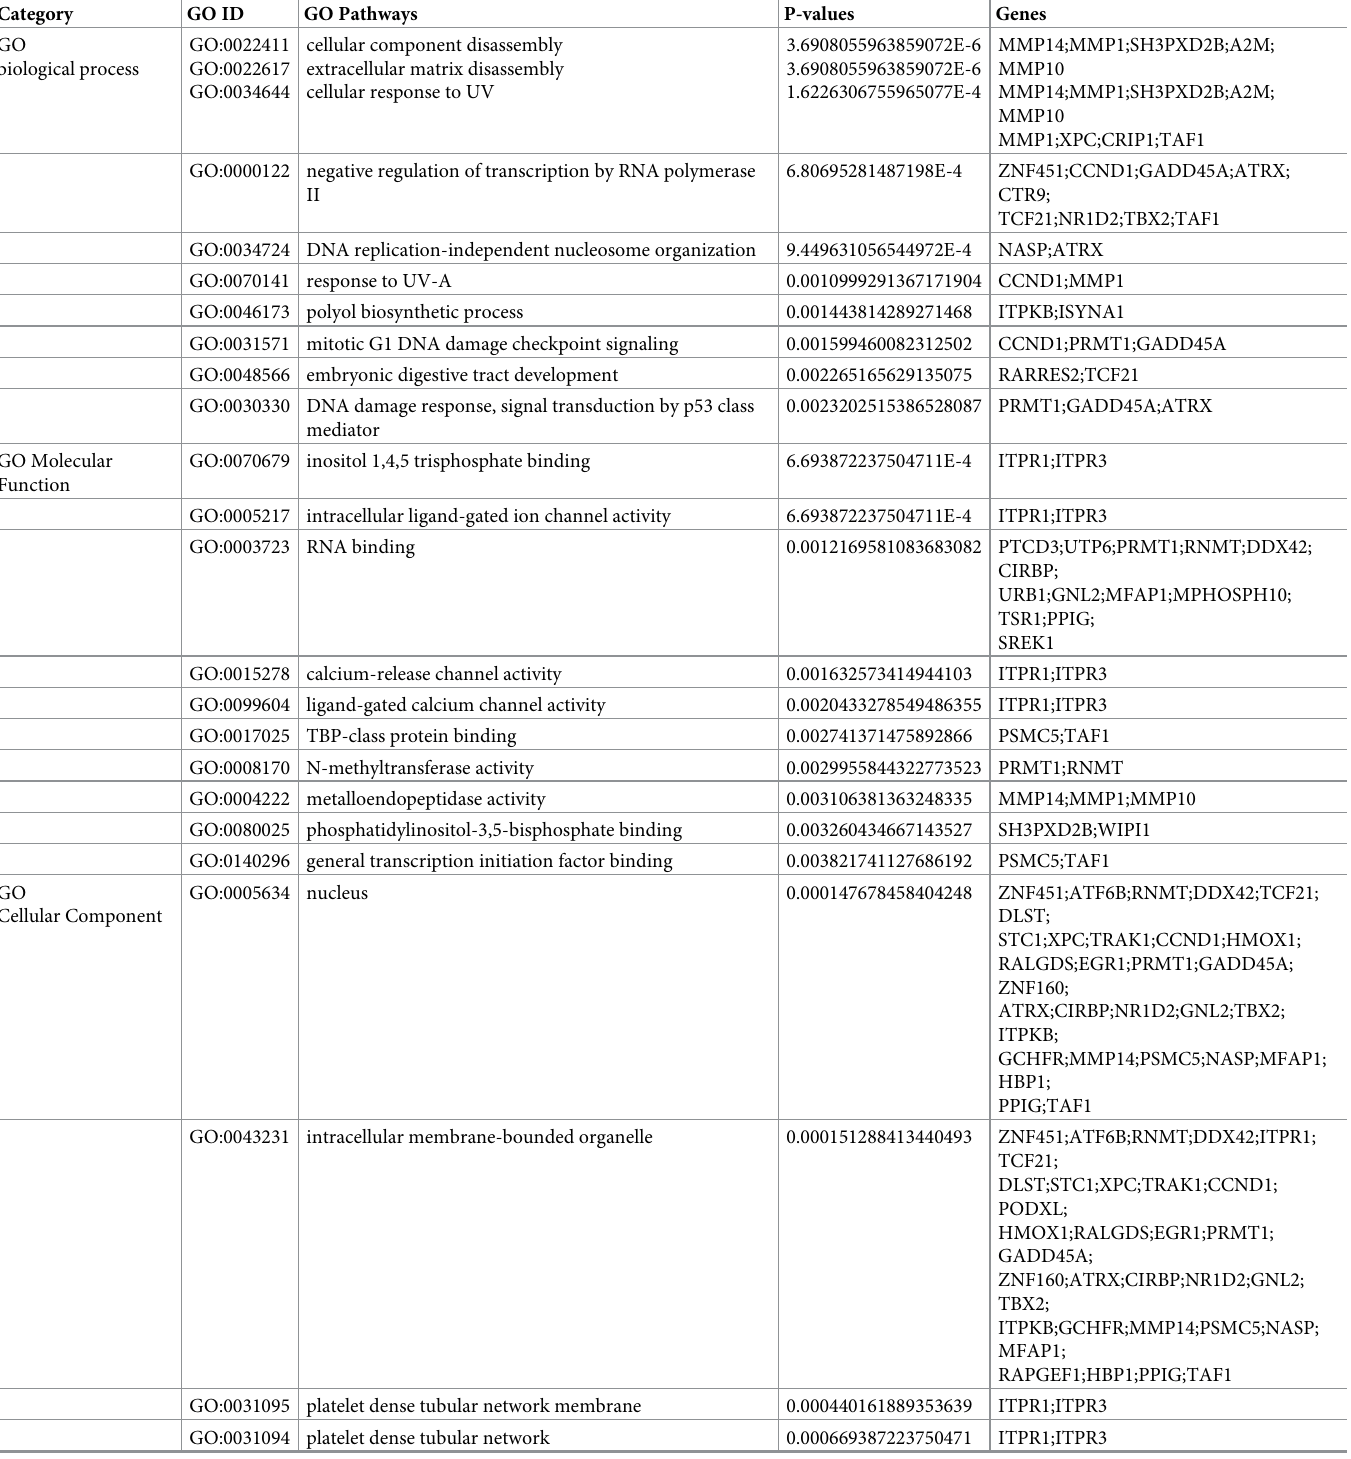
Table 2. Go enrichment analysis of downregulated DEGs between COVID-19 and IPF.